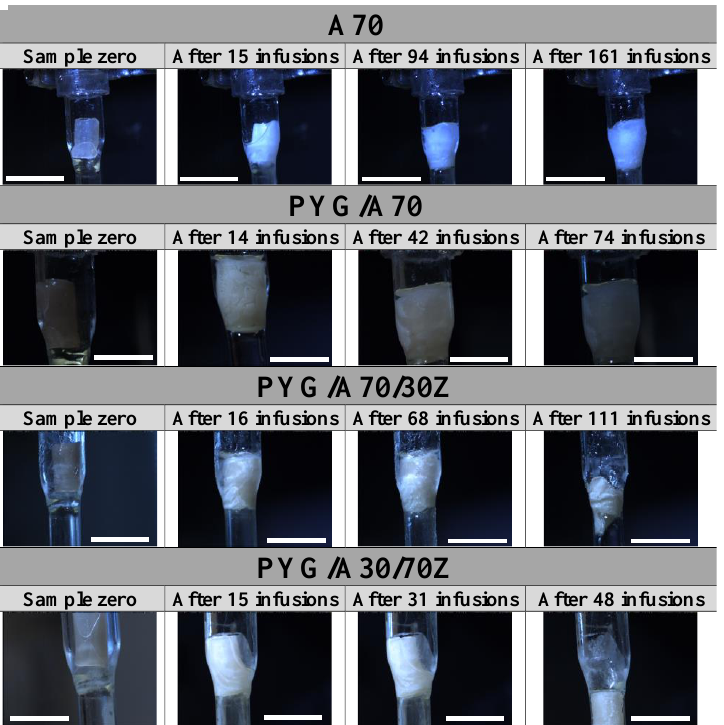
Figure 3. Images from resorption tests during the flow of the artificial urine through the tubular hydrogel samples of sodium alginate 70 mg/mL (A70), sodium alginate with Pygeum (PYG/A70), and sodium alginate – gelatin – Pygeum (PYG/A70/30Z, PYG/A30/Z70). Scale bar: 1 cm.